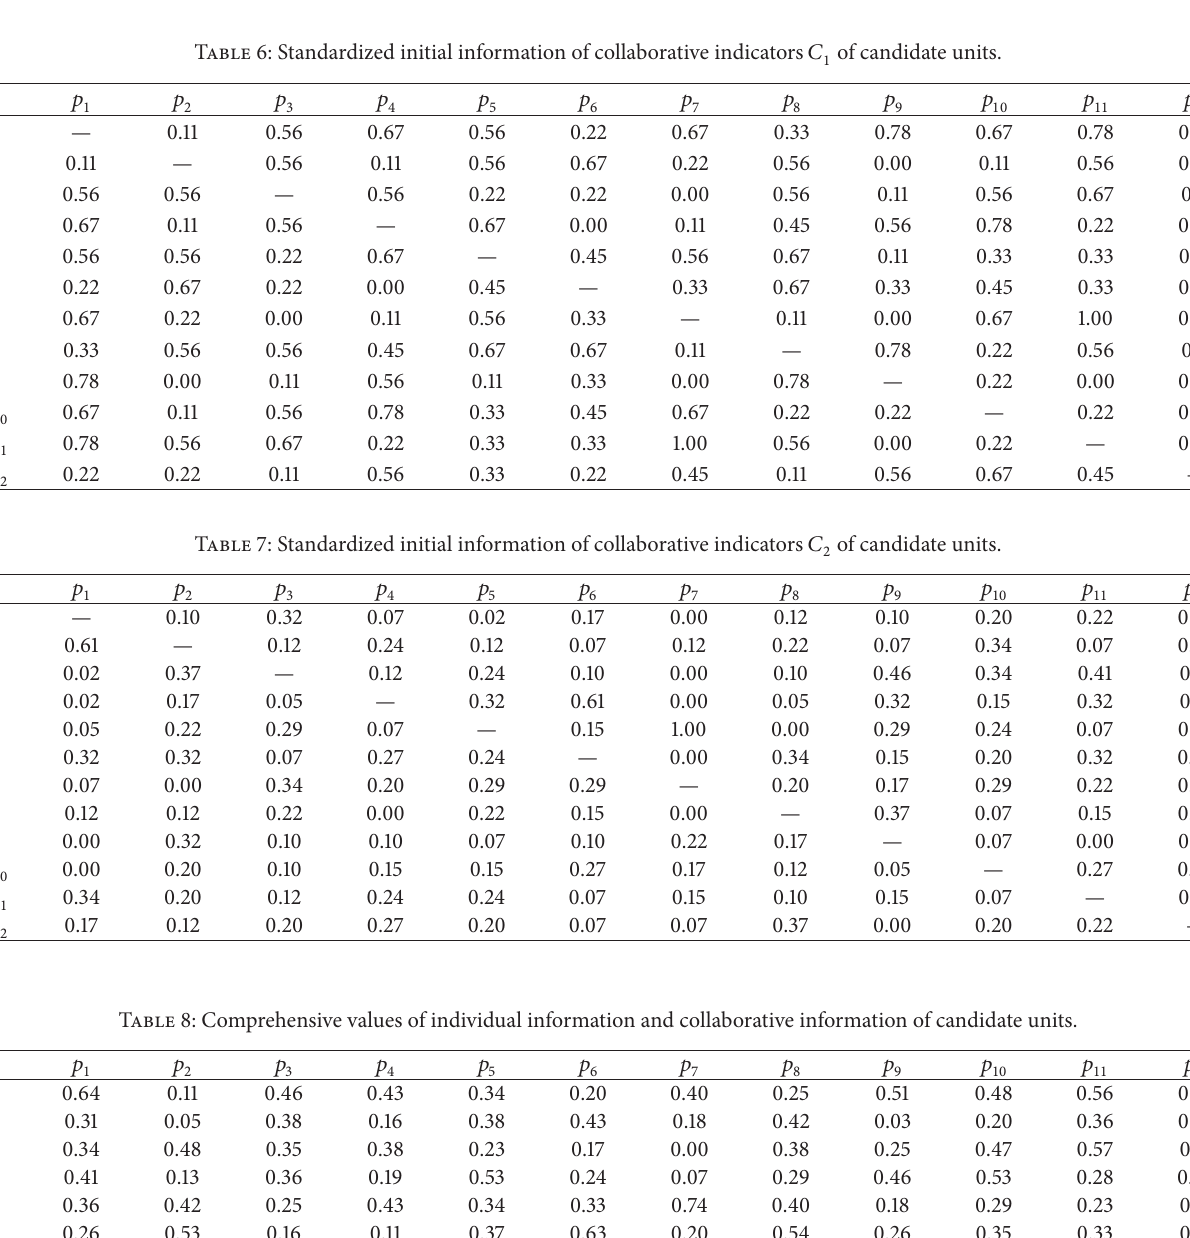
Table 6: Standardized initial information of collaborative indicators 𝐶 1 of candidate units.